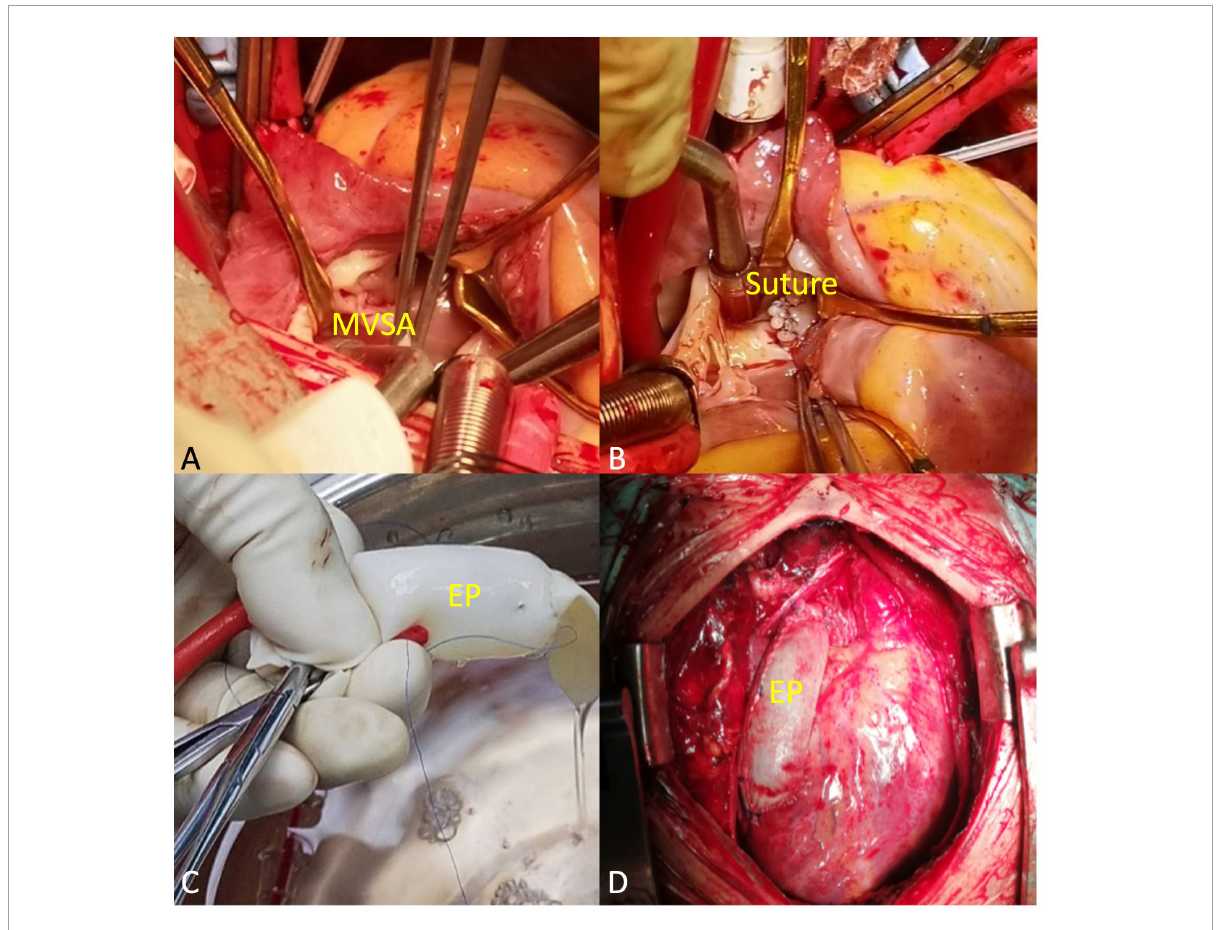
FIGURE3 Main procedural steps. (A) The membranous ventricular septal aneurysm (MVSA) was positioned toward the right ventricular outflow tract (RVOT). The arrowheads to MVSA. (B) MVSA was resected, and the residual membranous part of the interventricular septum was directly stitched. The arrowheads to the suture. (C) The extracardiac pipe (EP) made by a bovine pericardial patch was tested before connection. (D) EP completed the connection between the right ventricle and the pulmonary